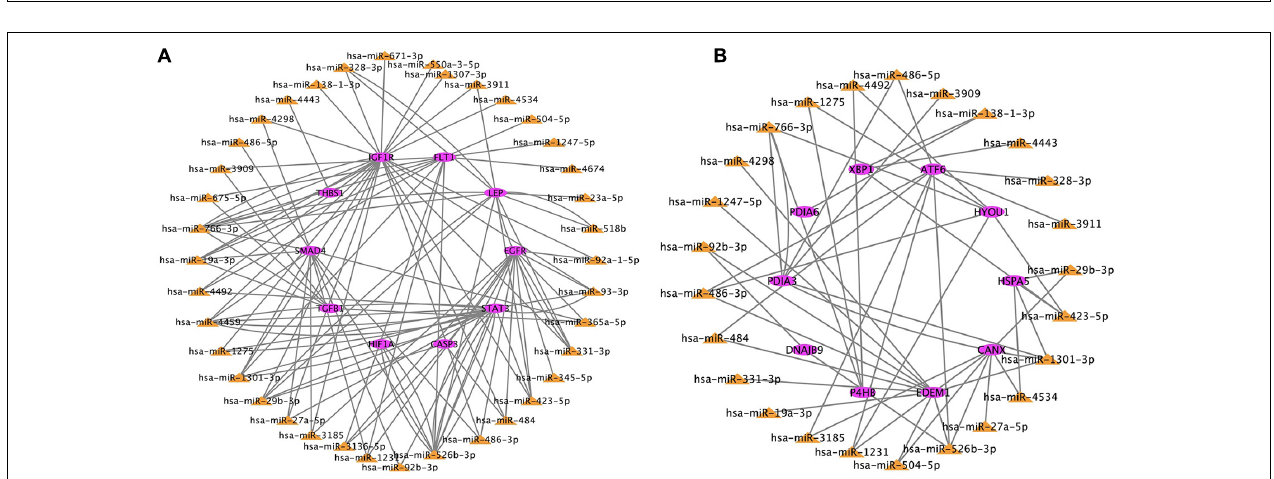
FIGURE 6 | Protein–protein interaction network for the candidate genes. Significant modules related to (A) hypoxia and (B) endoplasmic reticulum.